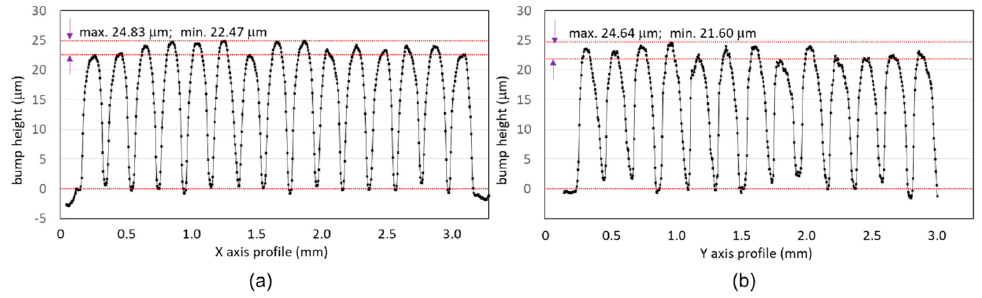
Figure 9. Bump height measurement results: distributions along the ( a ) x axis and ( b ) y axis.